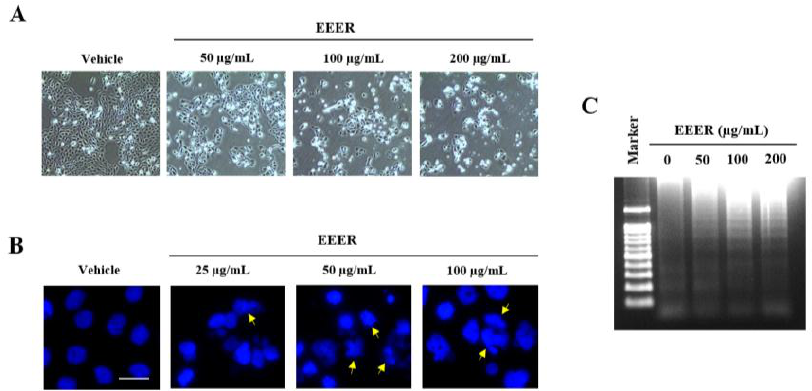
Figure 4. Effect of EEER on apoptosis in BPH-1 cells. Cells were treated with vehicle or EEER for 24 h at the indicated concentrations. ( A ) Representative images of cell confluence and morphology observed under a phase-contrast microscope (magnification 100 × ). ( B ) Representative images of DAPI-stained cells observed under a fluorescence microscope (scale bar, 20 µ m). The arrows indicate signs of apoptotic morphology, including chromatin condensation and apoptotic bodies. ( C ) Fragmentation of genomic DNA as analyzed by agarose gel electrophoresis. Images are representative of three independent experiments.